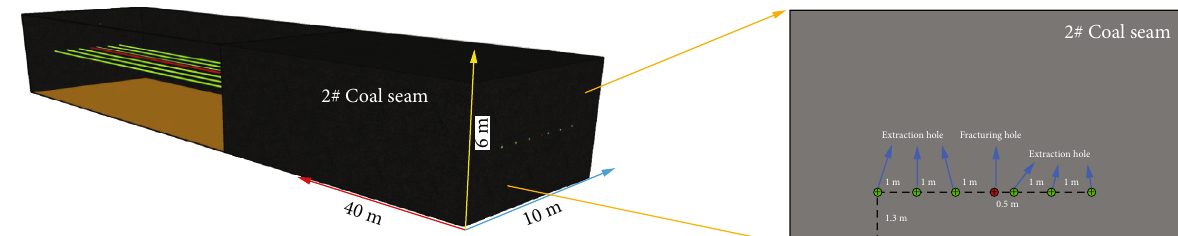
Figure 22: In fl uence range of carbon dioxide fracturing inspection borehole arrangement.